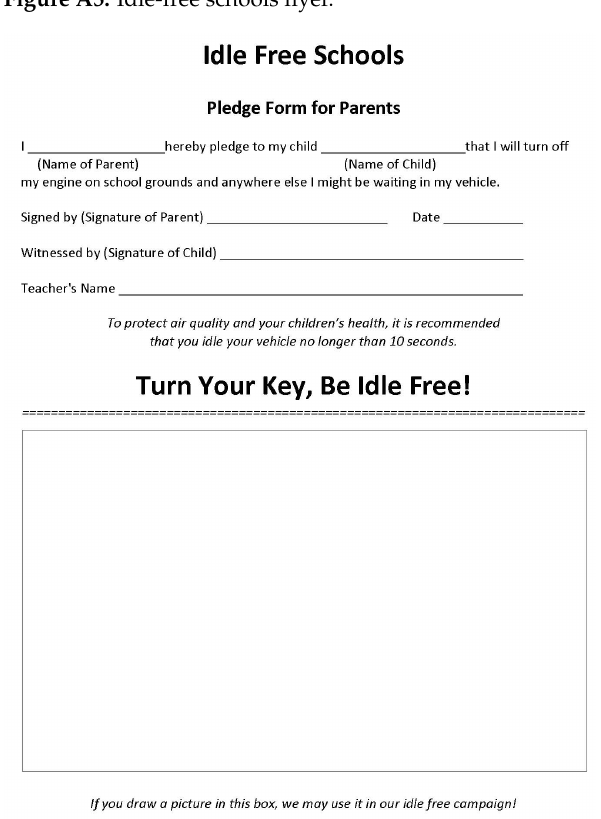
Figure A6. Idle-free schools pledge form for parents.